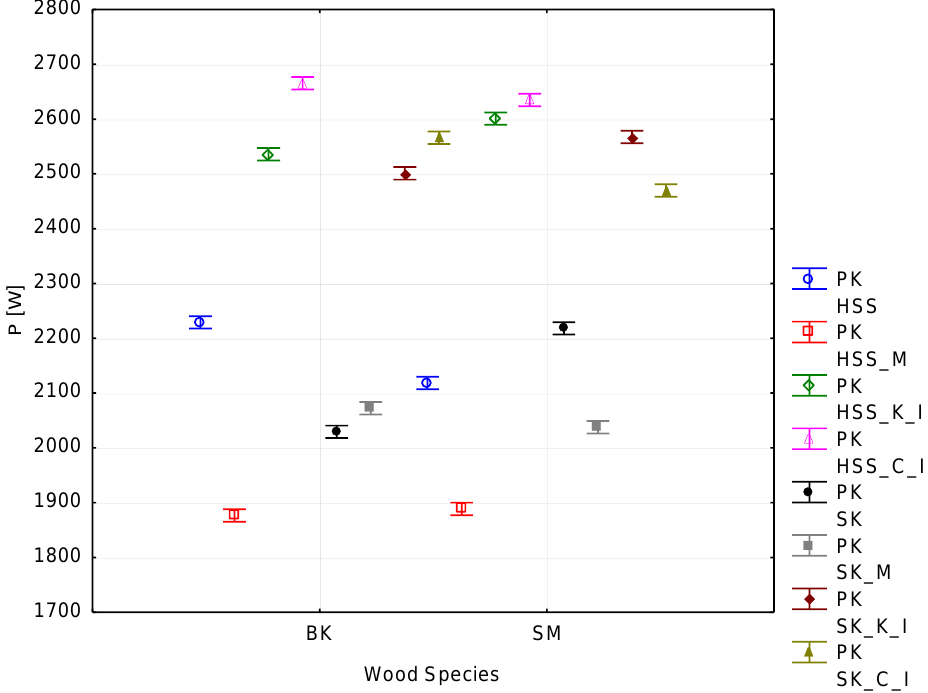
Figure 9. Average performance values depending on the coating and wood used .